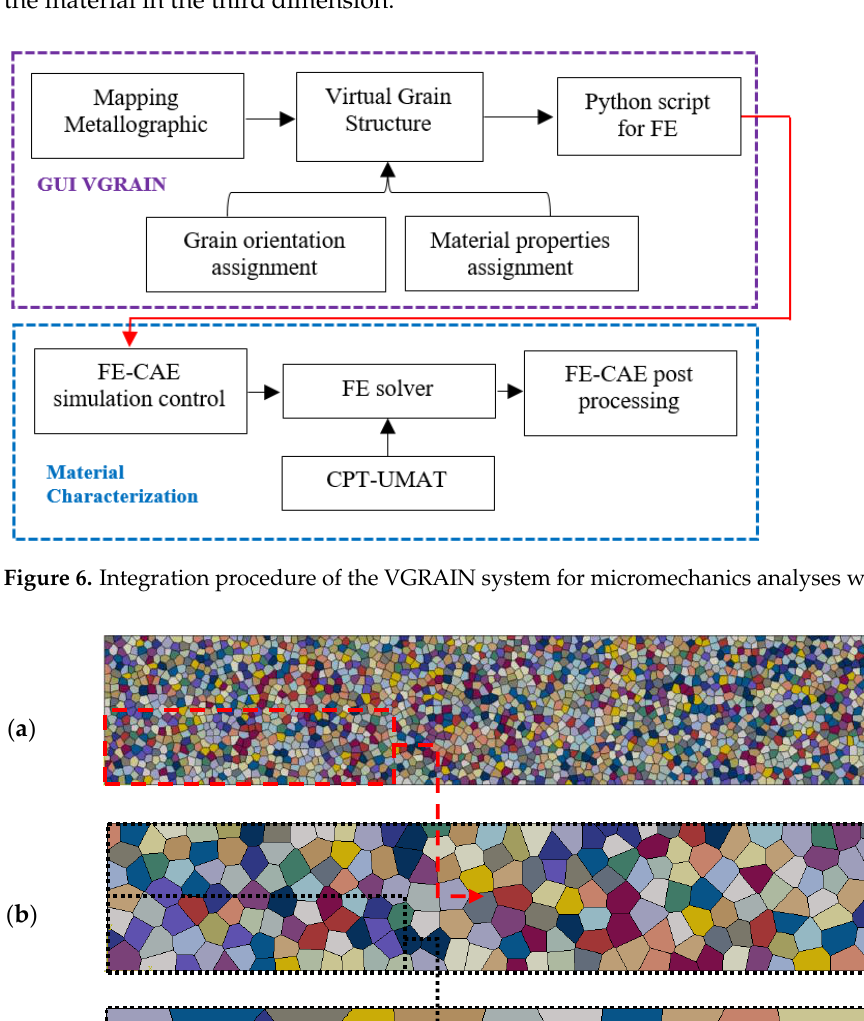
Figure 6. Integration procedure of the VGRAIN system for micromechanics analyses with CPT.